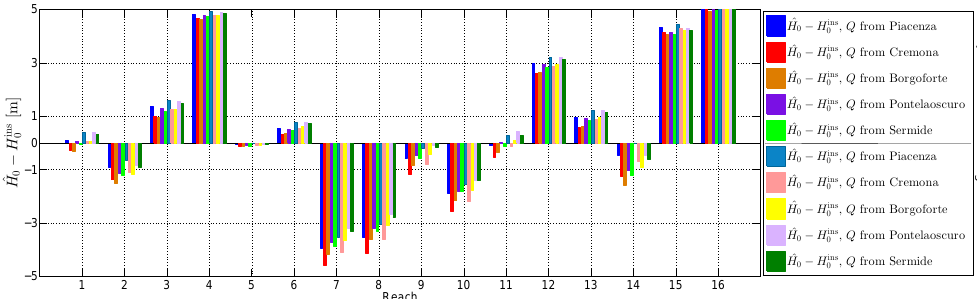
Figure 10. Bar plot of difference between estimated riverbed’s height (cid:99) H 0 and those from in situ using discharge data of different gauging stations along the Po